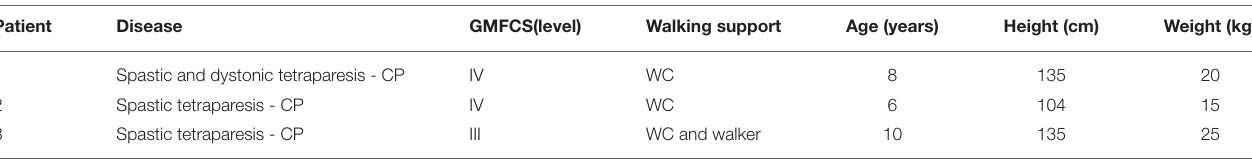
TABLE 2 | Patients’ description.